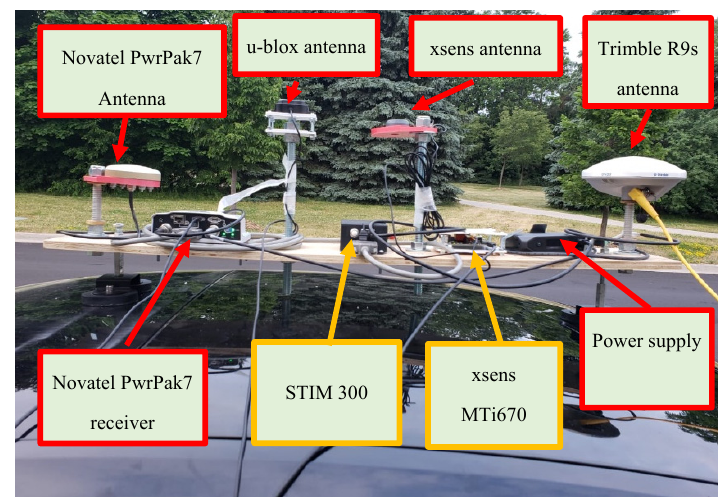
Figure 2. Sensors set up on vehicle’s rooftop.